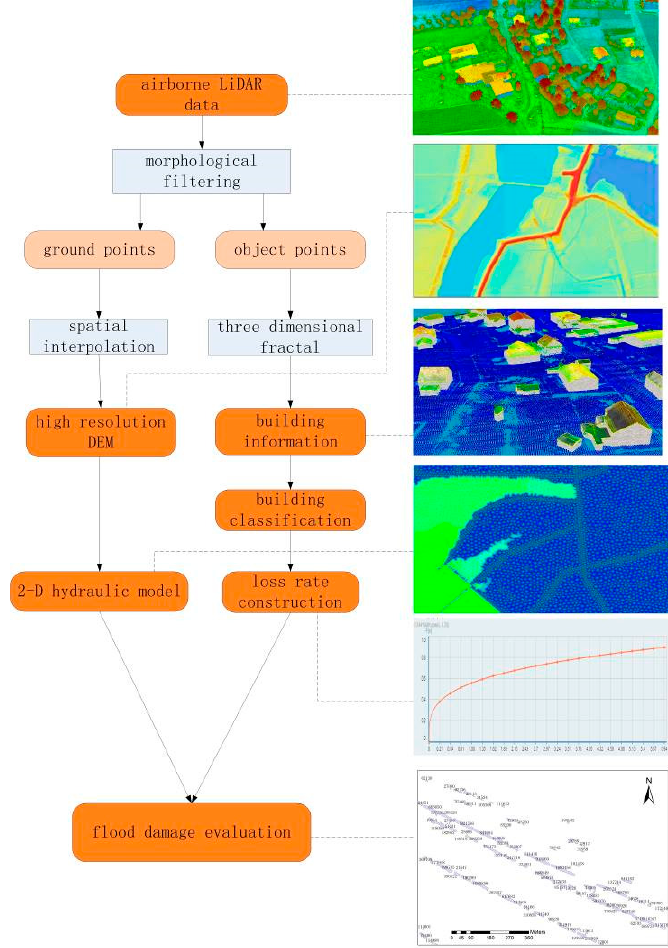
Figure 4. Flow chart of analytical process.